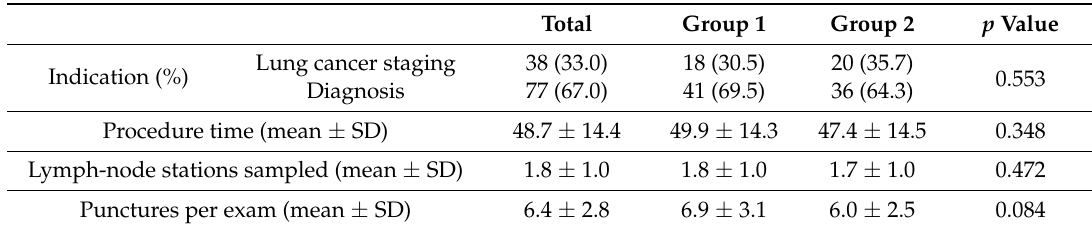
Table 4. EBUS-TBNA technical information.